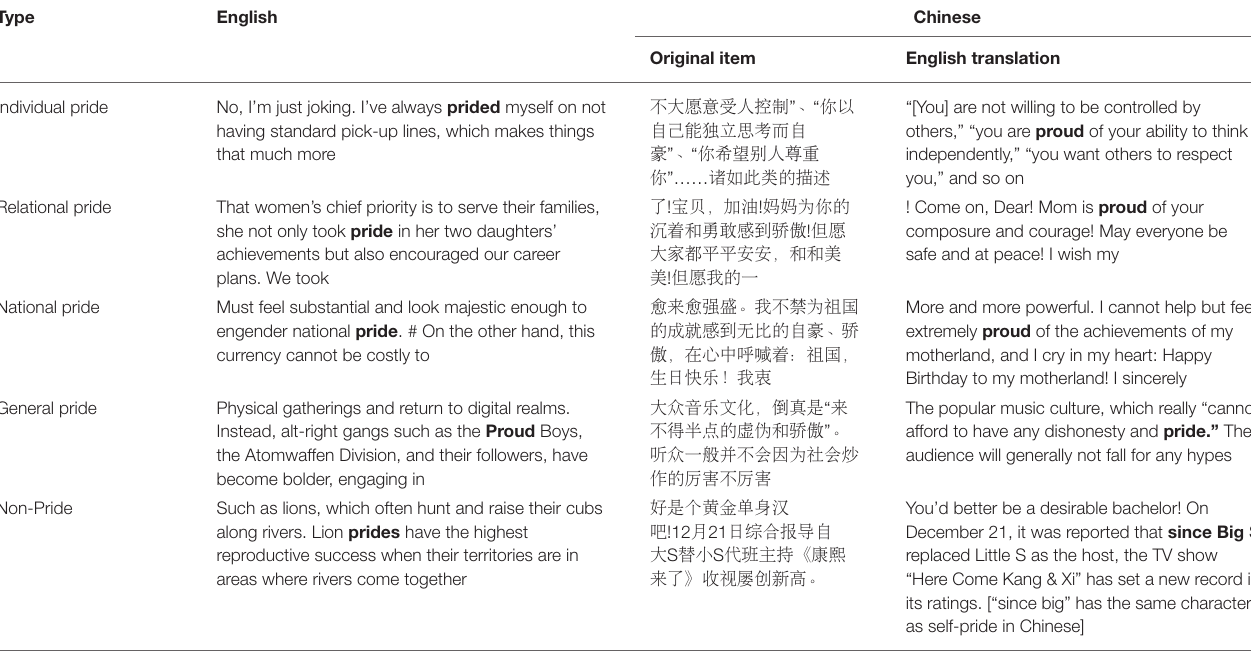
TABLE 1 | Examples of individual pride and collective pride.